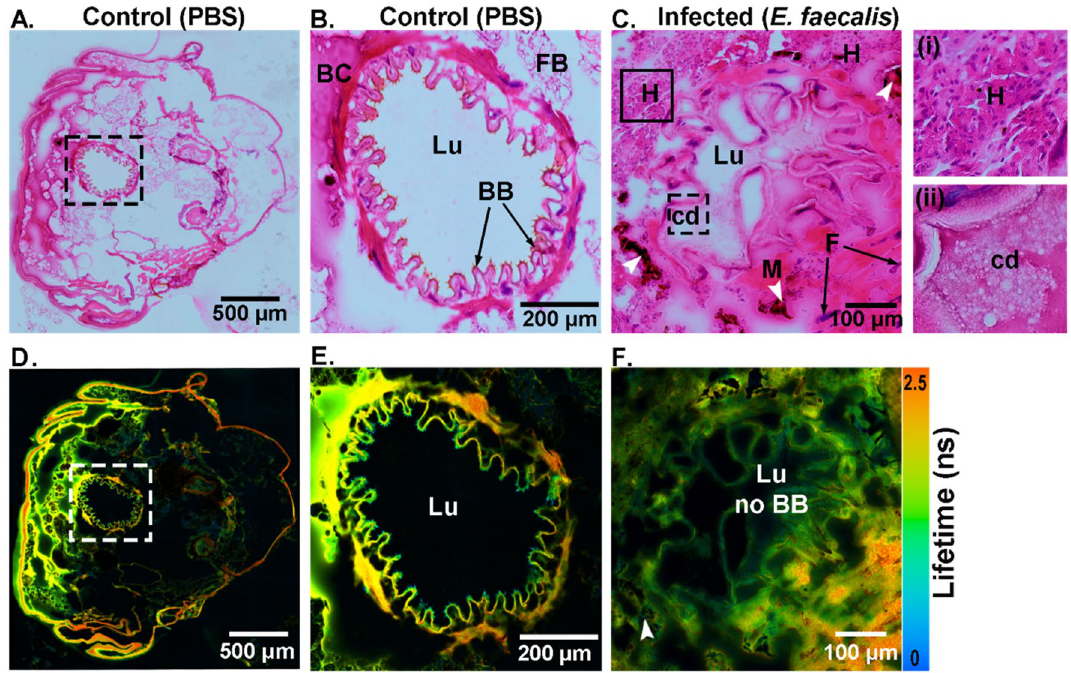
Figure 2. Visualization of the transverse section of the control ( A , D ) and E. faecalis infected ( C , F ) tissue from G. mellonella larvae. ( A–C ) HE stained images of tissue sections. ( D–F ) FLIM images illustrate transverse sections corresponding to endogenous fluorophores such as flavins and lipo-pigments with differing lifetime information as false-color images ranging from blue to red (scale 0–2.5 ns). The squared-dashed sections in ( A , D ) have been zoomed-in and are shown in ( B , E ), respectively. The squared inset with a solid line in ( C ) is zoomed-in and shown in ( i ), and the squared inset with a dashed line in ( C ) is shown in ( ii ). BB = brush border, Lu = lumen, FB = fat body, BC = body cavity, cd = cell damage, F = cytoplasmic fragmentation, M (white arrowheads) = melanization, H = areas with hemocyte